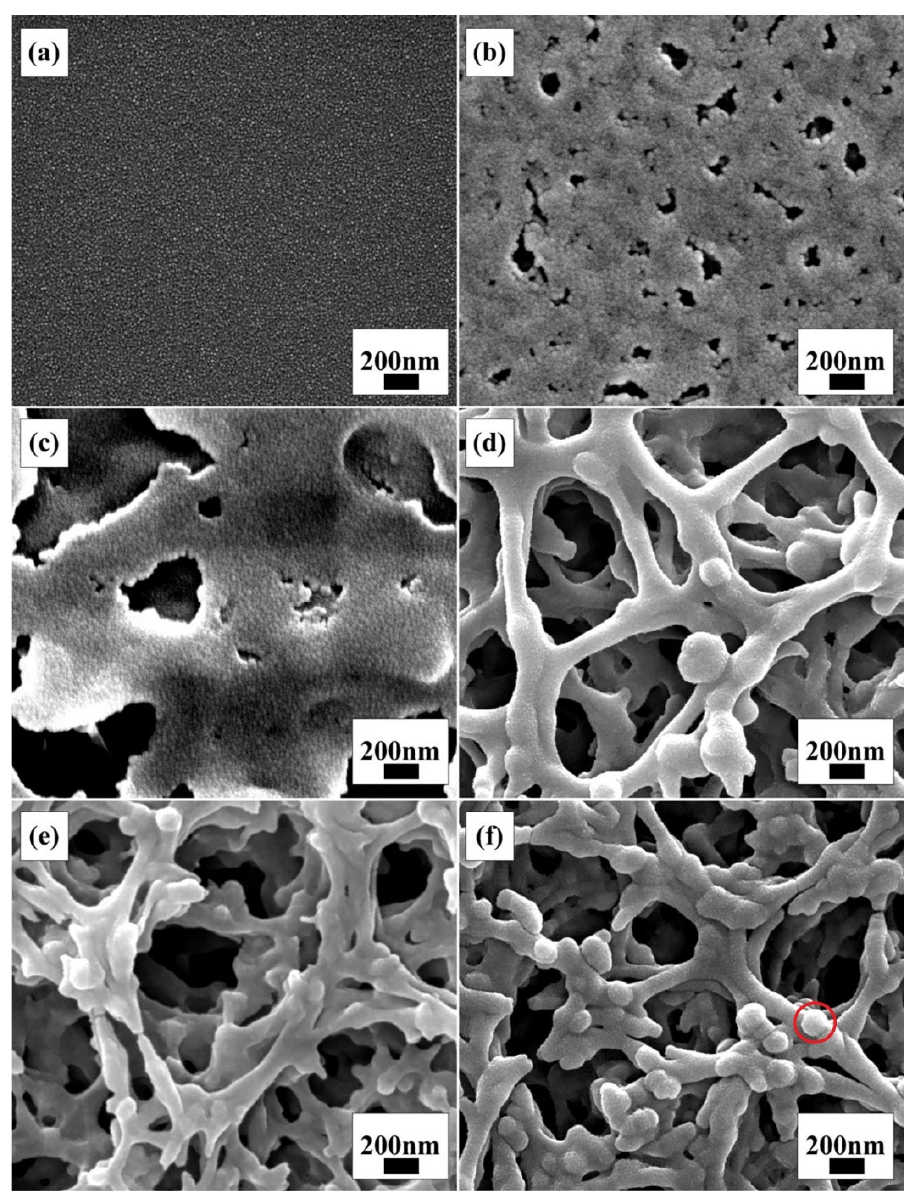
Figure 7. SEM images of seven ‐ layer films prepared with different molar ratio values of POGTA/TTB: ( a ) the molar ratio of POGTA/TTB was 0; ( b ) the molar ratio of POGTA/TTB was 0.2; ( c ) the molar ratio of POGTA/TTB was 0.3; ( d ) the molar ratio of POGTA/TTB was 0.6; ( e ) the molar ratio of POGTA/TTB was 0.7; ( f ) the molar ratio of POGTA/TTB was 0.8. After assembling the DSC, the corresponding I–V test results are shown in Figure After coating multiple times, the morphological characteristics of the film of each ra ‐ tio were similar to the corresponding single ‐ layer film. When POGTA/TTB = 0, the film was dense. When POGTA/TTB = 0.2, the film presented a porous structure. When